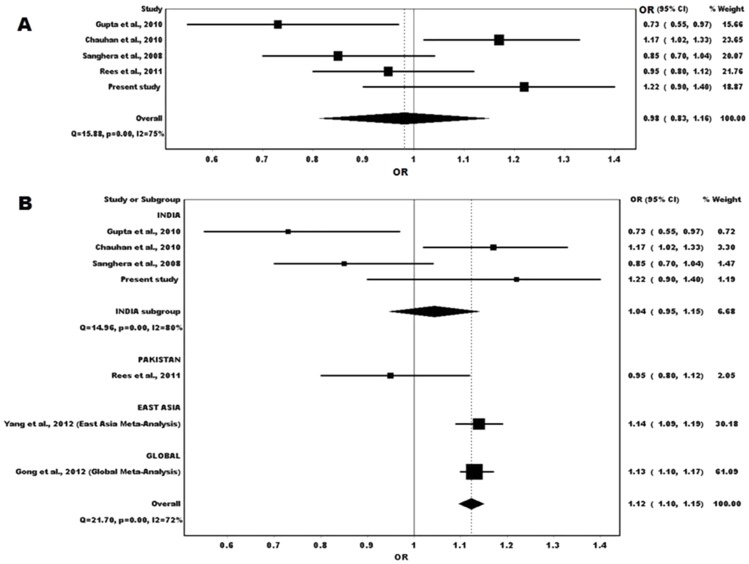
Meta-analysis for the studies of KCNJ11 polymorphism (rs5219) with T2D.A. Overall pooled OR of South Asian studies. B. Overall pooled OR and ORs within subgroups (South Asian (India and Pakistan) East Asian and Global) were shown. Black squares indicate the individual OR of the studies with size of each square being proportional to the study weighting in the meta-analysis and horizontal line representing the 95% CI. The black colored diamond represents the pooled OR